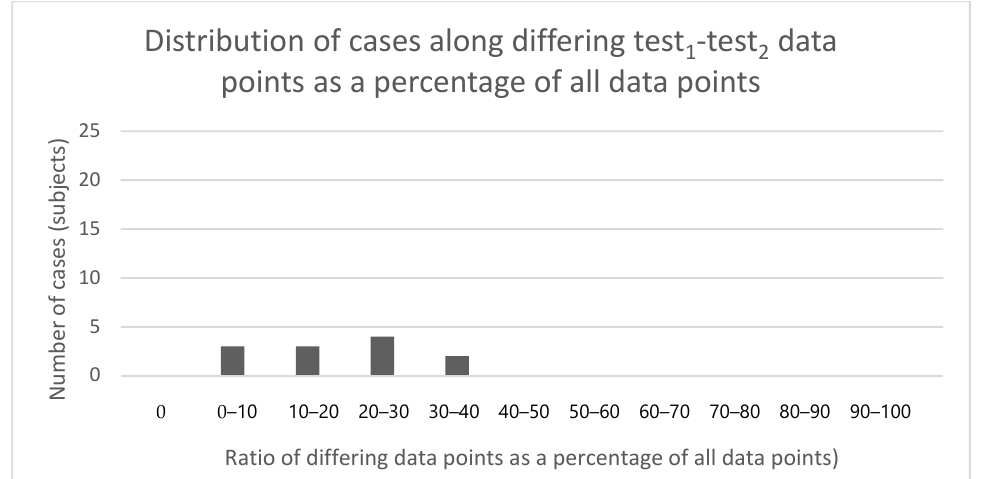
Figure 1. Histogram on the 12 subjects with nonidentical data series when comparing test 1 and test 2 datasets, along differing data points, as a percentage of all data points.